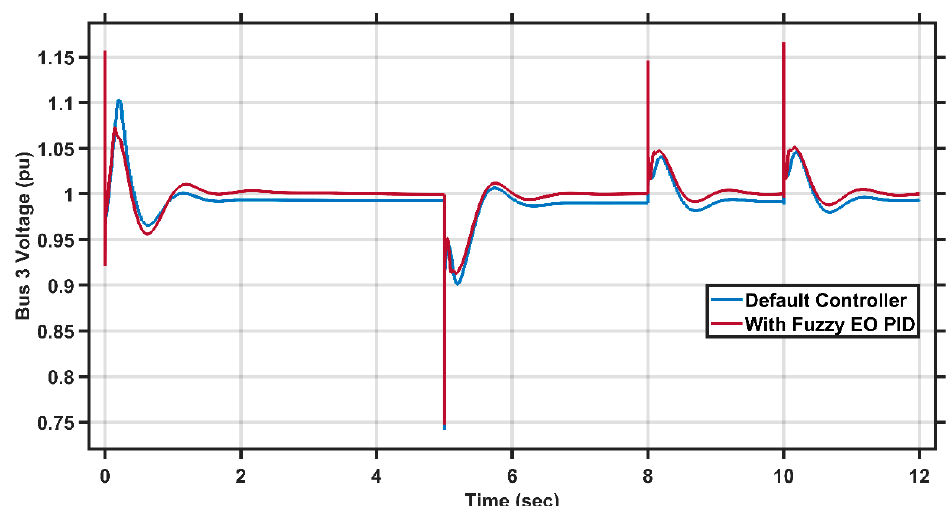
Figure 25. Bus 3 voltage at dynamic loading condition for the IEEE 9-bus system.